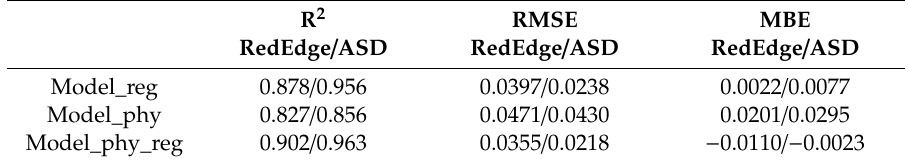
Figure 11. Validation results for the samples of vertical urban surfaces. Table 8. Validation results for vertical urban surface with measures of R 2 , RMSE, RSE, and MBE. R